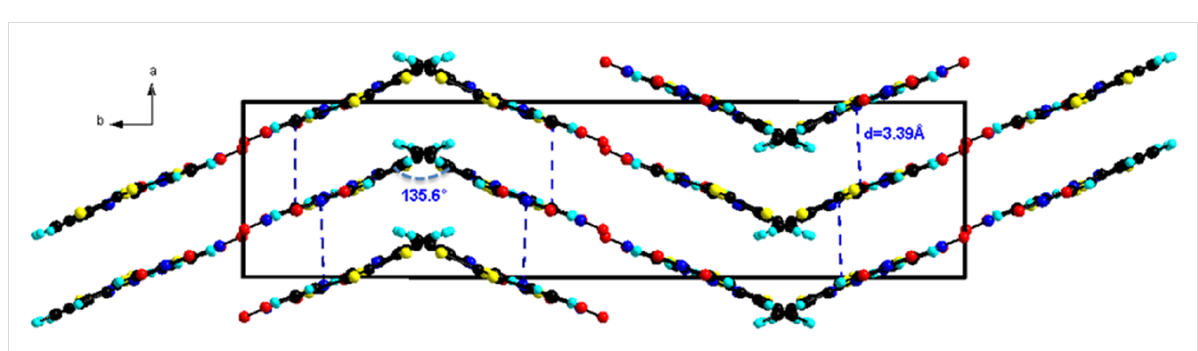
Figure 3: Packing diagram of L1 showing the orientation of the columns of head to tail dimers.